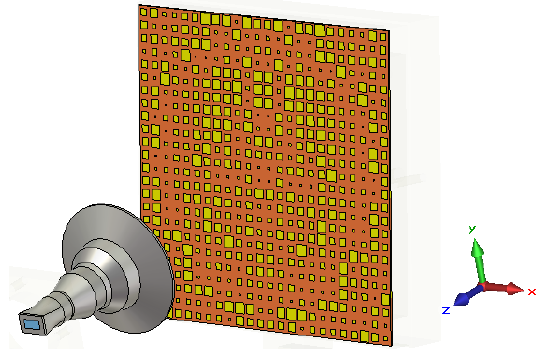
Figure 8. Layout of the optimized